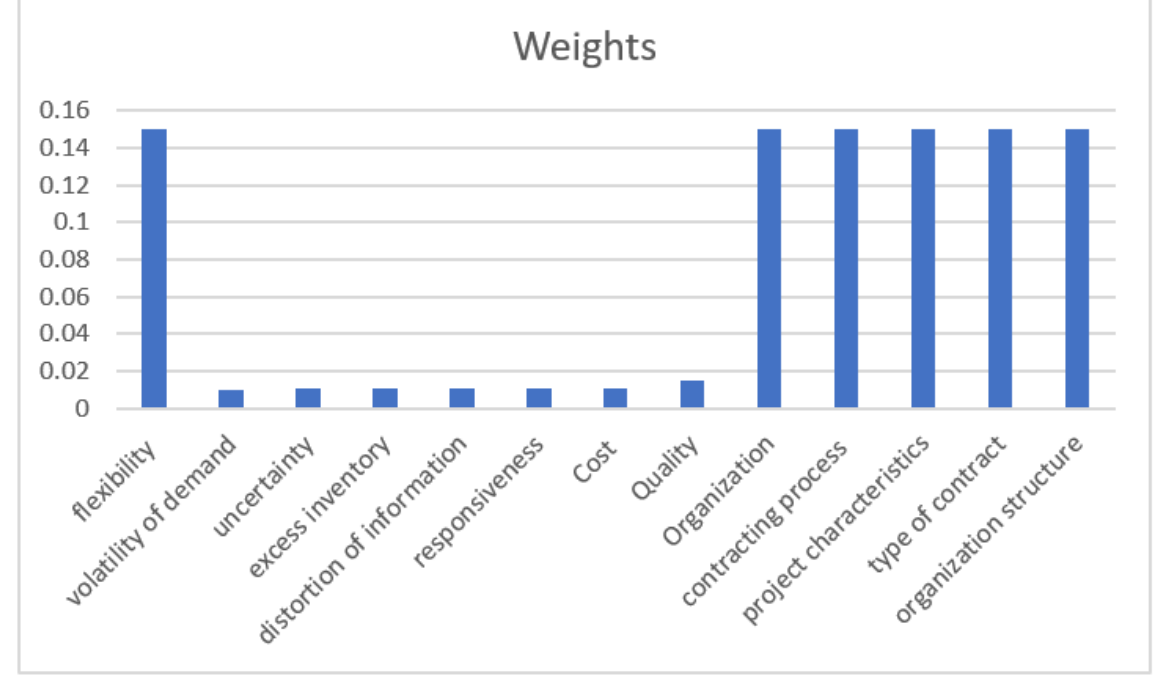
Figure 2. The final weight of BWM.